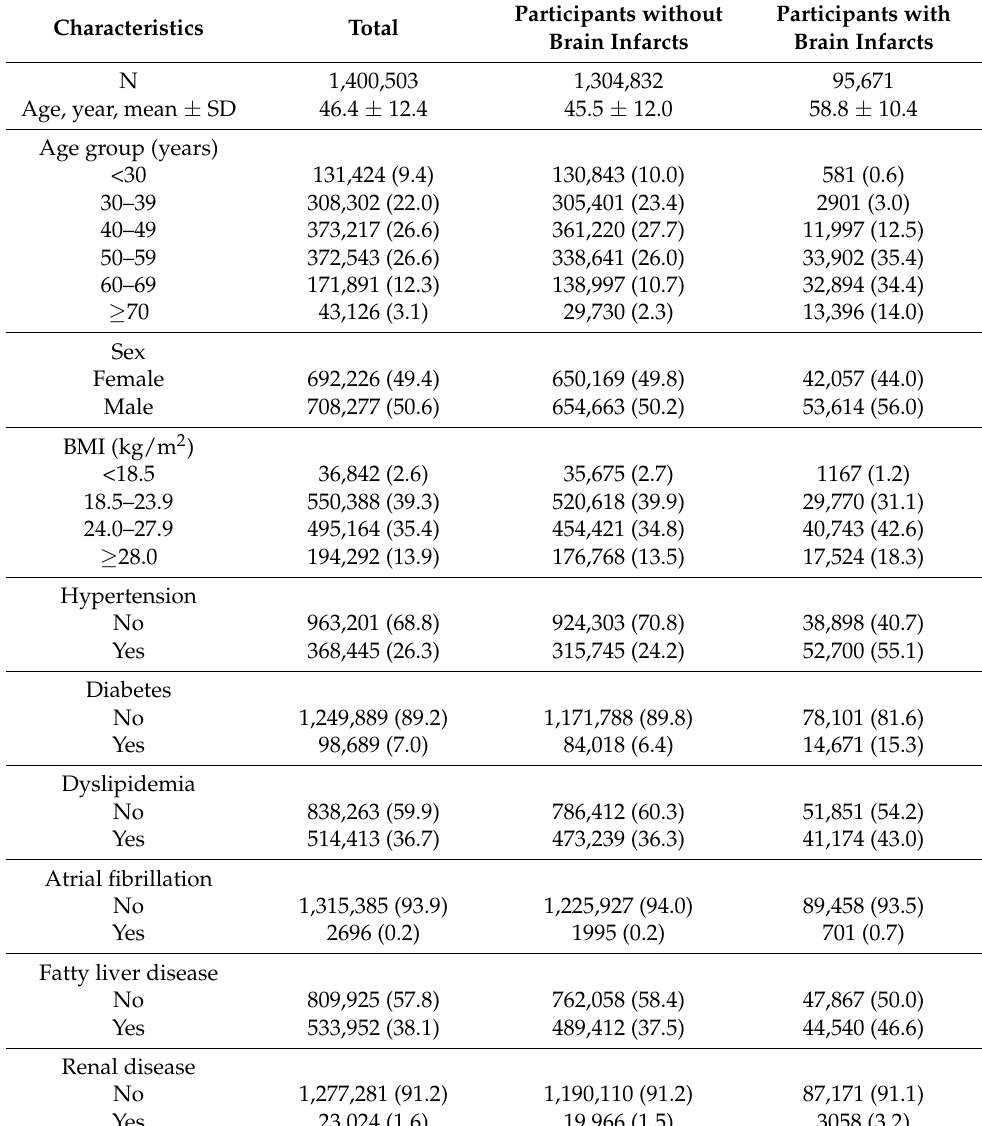
Table 1. Characteristics of study participants with and without brain infarcts (BI)